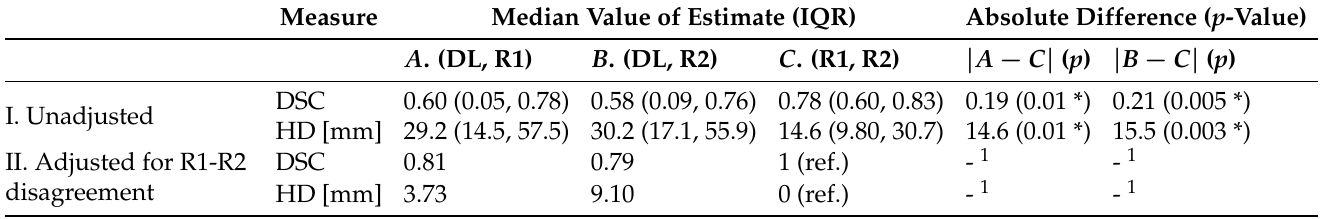
Table 3. Median (IQR = interquartile range) Dice score (DSC) and Hausdorff distance (HD) for tumor masks derived from DL (deep learning) segmentation compared to manual tumor segmentations by R1/R2. I: DL yields tumor masks with lower DSC and higher HD for DL-R1/R2 than that for R1-R2 (Wilcoxon rank sum, p ≤ 0.01 and p ≤ 0.01, respectively). II: Performance metrics of tumor masks after adjusting for median R1-R2 disagreement. The adjusted values yield higher DSCs and lower HDs for DL-R1/R2 when using DSC = 1 and HD = 0 as reference values for R1-R2 (ref. values). * Statistically significant; 1 Statistical testing and difference in estimates do not change from I to II; R1 = rater 1; R2 = rater